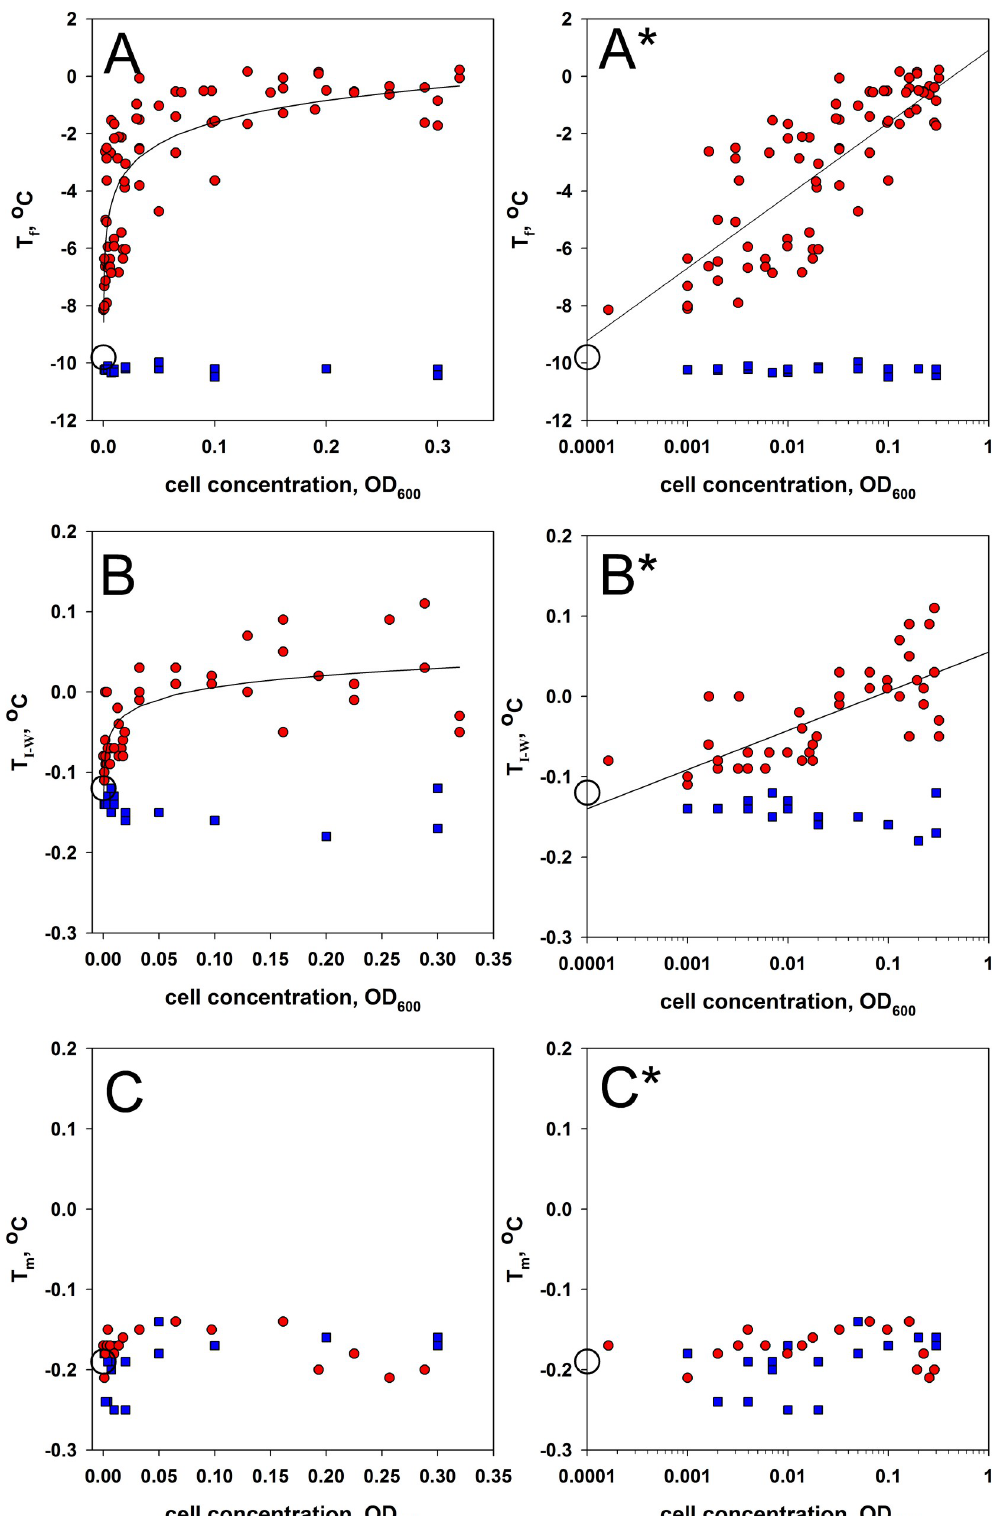
Fig 3. Dependence of T f (A, A � ), T i-w (B, B � ), and T m (C, C � ) on cell concentration. Figures marked with � are plotted on a logarithmic scale along the concentration axis. Red circles are for P . syringae solutions. Blue squares are for E . coli solutions. The empty circle shows T f , T i-w , or T m for cell-free buffer averaged across ten replicates. https://doi.org/10.1371/journal.pone.0265683.g003 PLOS ONE | https://doi.org/10.1371/journal.pone.0265683 May 12,